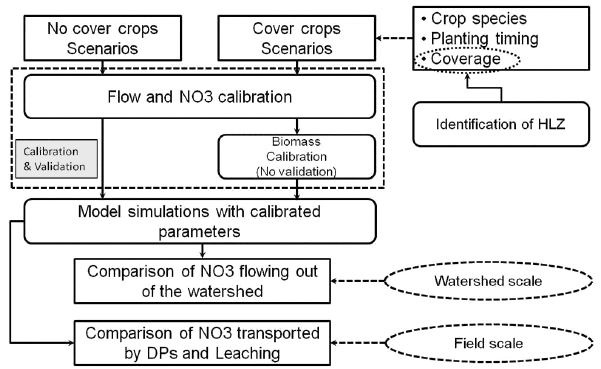
Figure 3. Schematic diagram of modeling procedure. Note: This shows the overall modeling procedure of the presented study and summarizes what simulation results are compared at the various spatial scales. HLZ (High Loading Zones) refers to those agricul- tural fields (HRUs) with high nitrate export